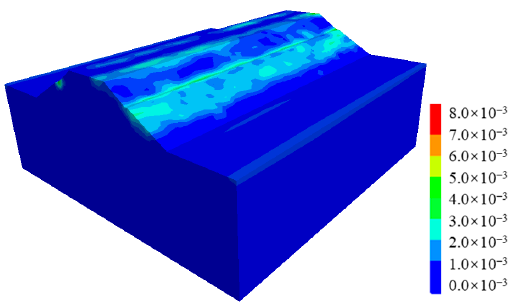
Figure 16. Plastic strain contour of the fill subgrade after earthquake.